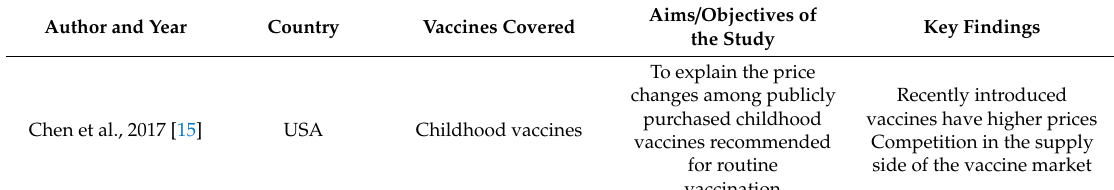
Table 2. Characteristics of studies